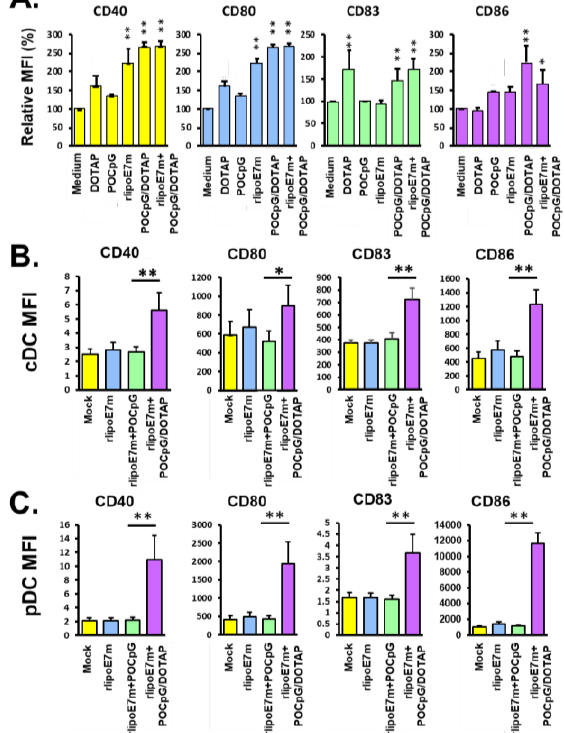
Figure 2. The combination of rlipoE7m and POCpG / DOTAP enhanced the expression of costimulatory molecules on BMDCs in vitro and in vivo. ( A ) Approximately 1 × 10 6 BMDCs were incubated with 100 nmole DOTAP, 10 µ g POCpG, 10 µ g rlipoE7m, 10 µ g POCpG-encapsulated 100 nmole DOTAP, rlipoE7m, and rlipoE7m plus POCpG / DOTAP combined in 1 mL culture medium for 18 h. The costimulatory molecules CD40, CD80, CD83, and CD86 on BMDCs were analyzed by flow cytometry after gating on CD11c + cells. The relative mean fluorescence intensity (MFI) was calculated by normalizing the MFI of the experimental groups to the MFI of the untreated medium control (each experimental group vs. medium control, * p < 0.05, ** p < 0.01). ( B and C ) C57BL / 6 mice were immunized via the tail vein. Conventional dendritic cells (cDCs) and pDCs were collected from spleens, and the indicated surface markers were analyzed by flow cytometry (each mouse group n = 6). The MFIs represent the level of surface marker expression. These data were collected and analyzed from three independent experiments. (The rlipoE7m + POCpG / DOTAP group vs. rlipoE7m + POCpG group, * p < 0.05, ** p < 0.01).